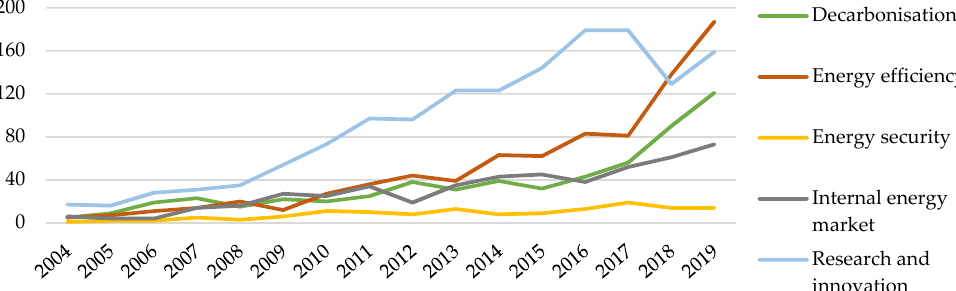
Figure 10. Number of articles featuring the Energy Union dimensions. Source: Authors; N = 3534.